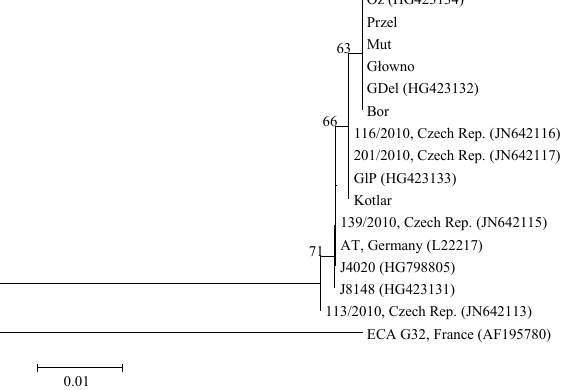
Figure 5. Phylogenic analysis of the nitroreductase and rhodanese-like protein sequences of 10 ‘ Ca. P. mali’ strains detected from a survey of apple trees in Central and South - ern Poland during 2010-2013 and strains available in Gen - Bank. ECA G32 strain of ‘ Ca . P. prunorum’ (AF195780) was included as outgroup. Phylogenetic trees were constructed by the neighbour-joining algorithm (MEGA 4.0) and the Kimura 3-parameter nucleotide substitution model in using 1,000 bootstrap replicates. Only bootstrap values higher than 60 are shown. The bar indicates the genetic distance as Kimura